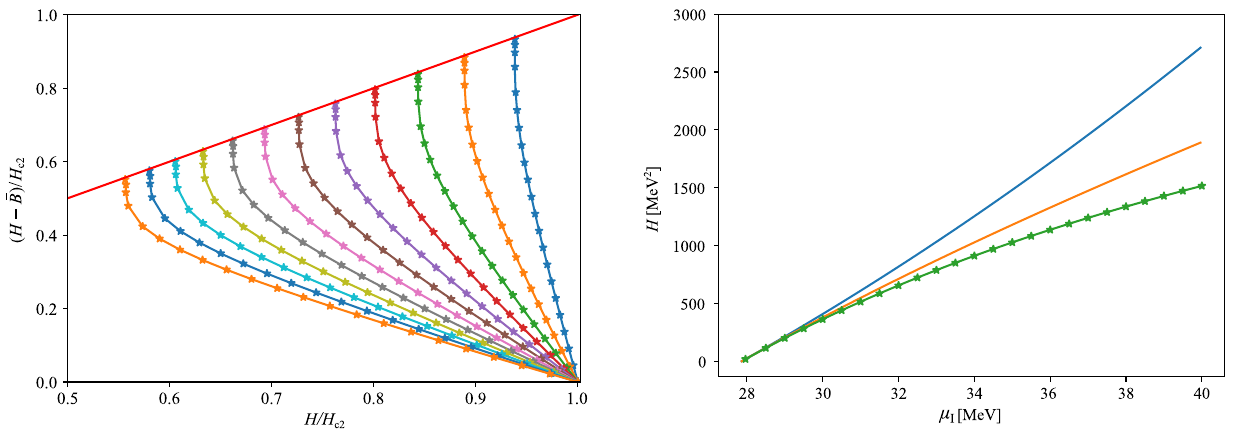
Fig. 2 Reverse magnetization of the Abrikosov vortex lattice as a function of H . To generate these data, the pion mass was tuned to m π = ef π ≈ 27 . 9 MeV. The different curves with data points dis- played correspond to different values of μ I with 1 MeV spacing. The right-most curve corresponds to μ I = 29 MeV and the left-most one to μ = 40 MeV I